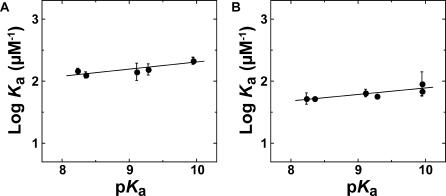
Dependence of the Affinity of a Series of
meta- and
para-Substituted Fluorophenolates for KSI
D40N on p
K
a
Data for pKSI
D40N is shown in (A) and data for tKSI
D40N is shown in (B), with slopes of 0.11 ± 0.03 and 0.10 ± 0.03, respectively.